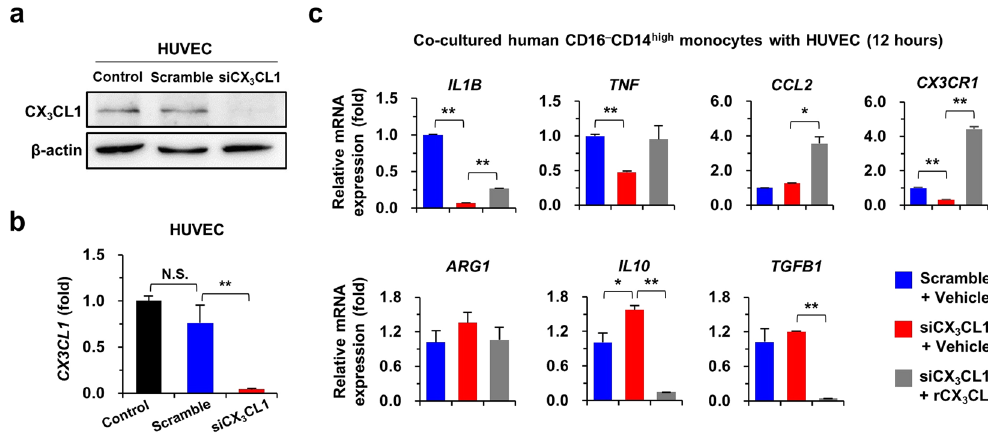
Figure 4. CX 3 CL1 of HUVECs promote pro-inflammatory phenotype of human CD14 high CD16 − monocytes. ( a , b ) Silencing of CX 3 CL1 expression was assessed by western blot ( a ) and quantitative reverse transcription PCR (qRT-PCR) ( b ) in HUVECs after small interfering RNA (siRNA) transfection. Original western blots are shown in Supplementary Fig. 3. ( c ) CD14 high CD16 − monocytes of human PBMCs were co-cultured with HUVECs for 12 h with or without treatment of recombinant CX 3 CL1. Co-cultured CD14 high CD16 − monocytes were subjected to qRT-PCR analysis. Data are expressed as the mean ± SEM. * p < 0.05, ** p < 0.01 compared to corresponding control. The results represent three independent